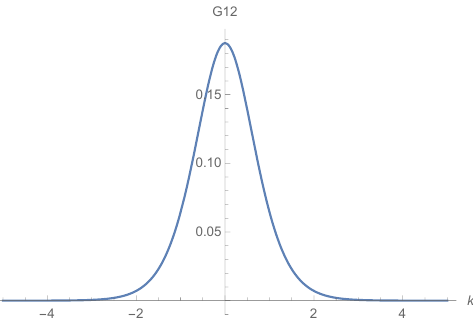
as a function of k . The correlator is (cid:12)nite and 2